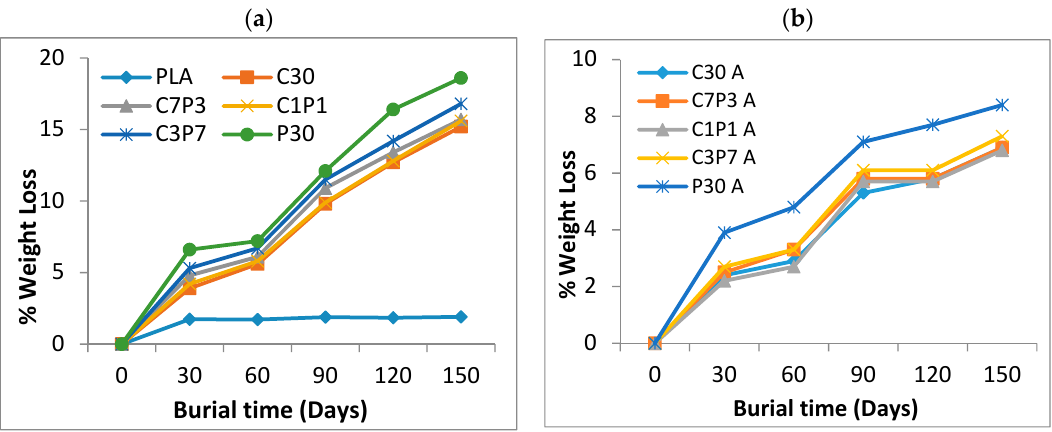
Figure 5. Weight loss (%) of ( a ) PLA and untreated CF / PALF / PLA biocomposites and of ( b ) alkali-treated CF / PALF / PLA biocomposites.